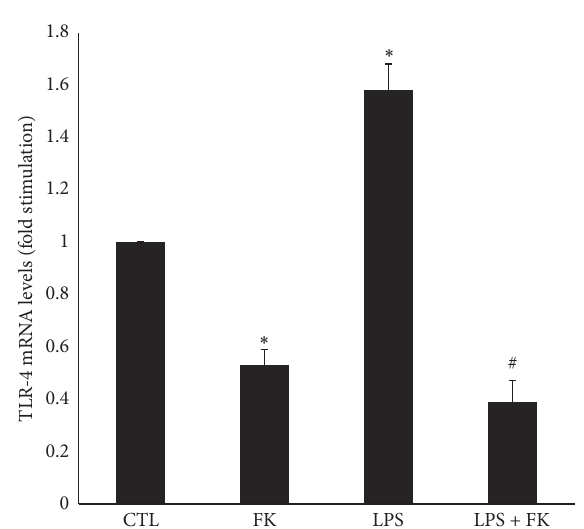
Figure 3: mRNA expression of TLR-4 in differentiated 3T3-L1 cells treated with LPS in the presence or absence of FK. Differentiated 3T3-L1 cells were treated as described in Materials and Methods under the following conditions: CTL, 10 𝜇 M FK, 1 𝜇 g/mL LPS, and LPS+FK.TheresultsareexpressedasmRNAlevels(foldstimulation over CTL set to 1) and are the means ± SEM of 3 independent experiments. Data were analyzed using 𝑡 -test for unique sample and paired 𝑡 -test; ∗ 𝑝 < 0.05 versus CTL; # 𝑝 < 0.05 versus LPS.